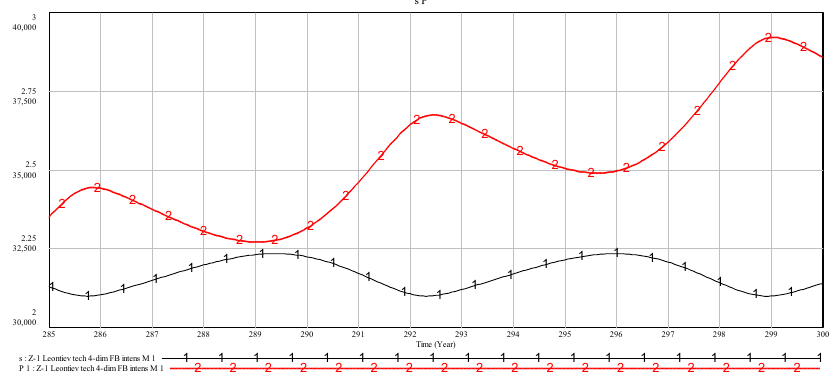
Fig. 9 Counter-phases of net output q (2) and capital-output ratio s (1) in industrial cycles resulting from